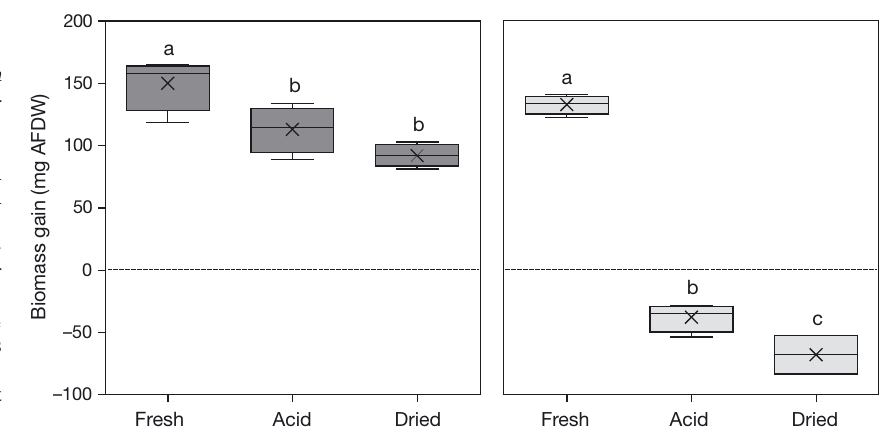
Fig. 1. Biomass gain of (A) Capi tella sp. and (B) Ophryotrocha craigs - mithi fed 3 different diets (fresh, acid-preserved and oven-dried). Bio mass gain was calculated based on total biomass at the start and end in each experimental chamber. Boxes represent the interval be- tween the lower and the upper quartiles of the distribu tions. Crosses are the mean values (n = 4 tanks treatment −1 ). Ver tical bars show minimal and maximal values. Boxes lacking a common subscript letter differ significantly (p < 0.05)